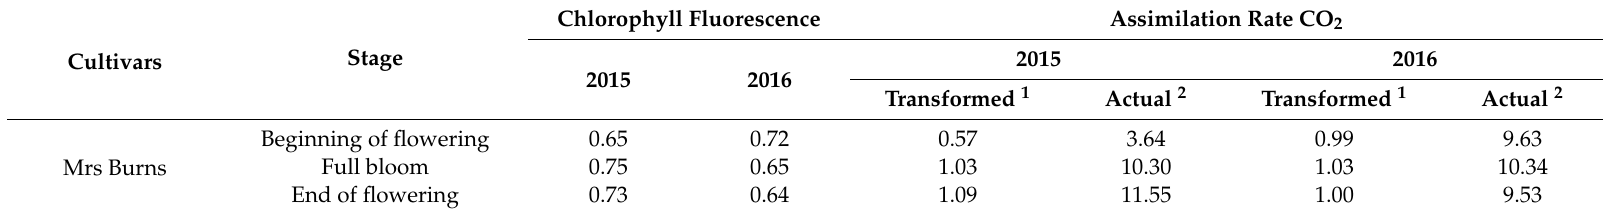
Table 5. Combined e ff ect of Years (2015, 2016), Cultivars and Stages of development on Chlorophyll Fluorescence and Assimilation rate CO 2 . Data presented are mean values, where LSD is the least significant di ff erence at the 0.05 significance